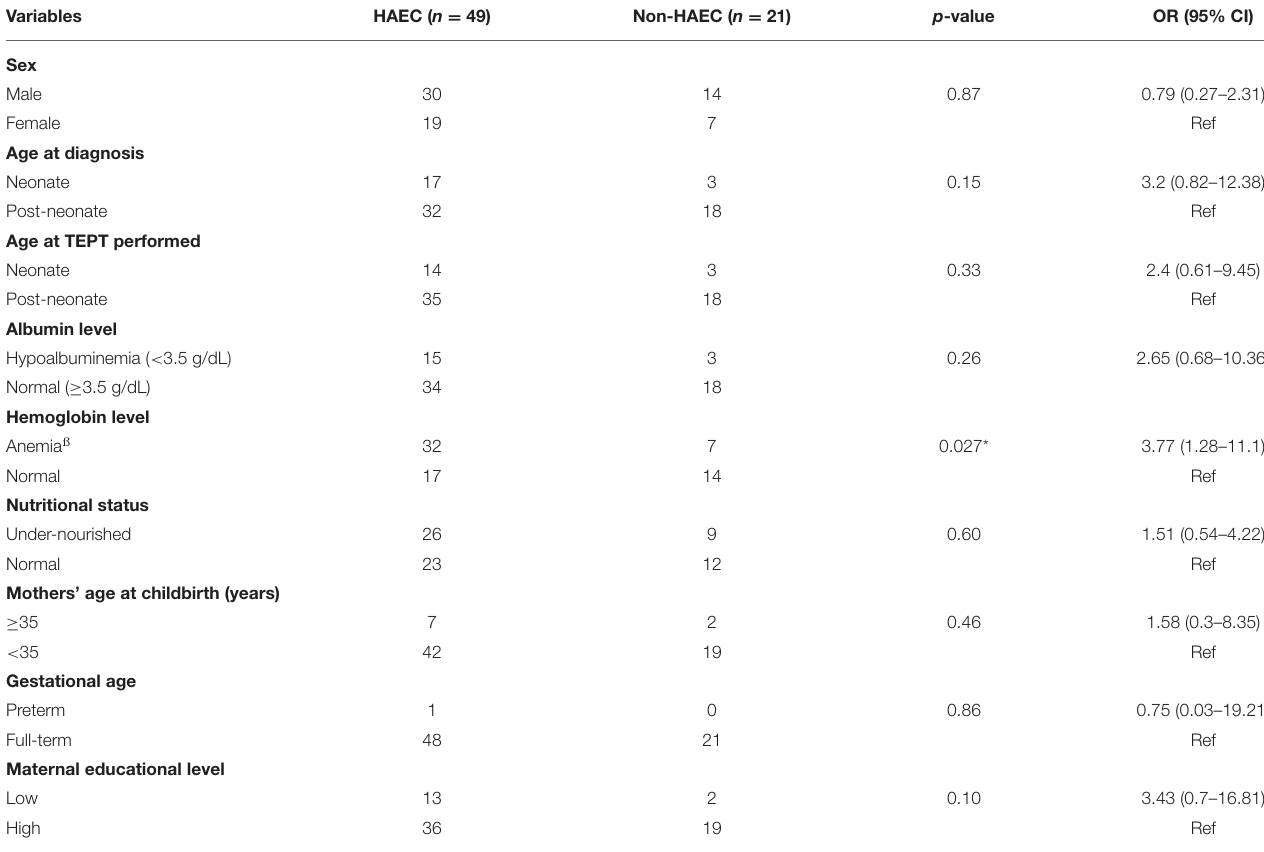
TABLE 3 | Association between risk factors and HAEC after TEPT using cut-off value of ≥ 4.